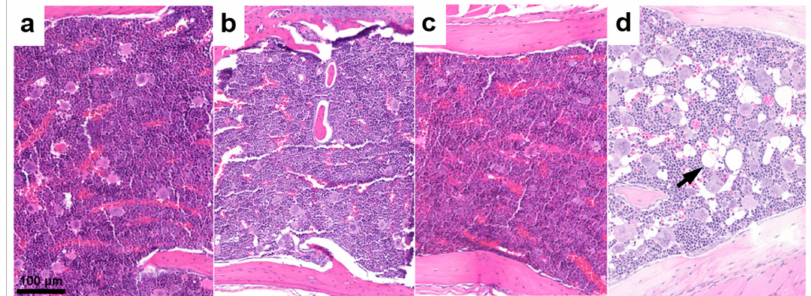
Figure 4. Representative histological findings in the bone marrow (sternum) of mice euthanized two weeks after injection of the radiofolates. ( a ) Tissue of a control mouse that received saline; ( b ) tissue of a mouse treated with 25 MBq 47 Sc-folate; ( c ) tissue of a mouse treated with 20 MBq 177 Lu-folate; ( d ) tissue of a mouse that received 10 MBq 90 Y-folate. The number of hematopoietic cells is reduced and replaced by adipocytes